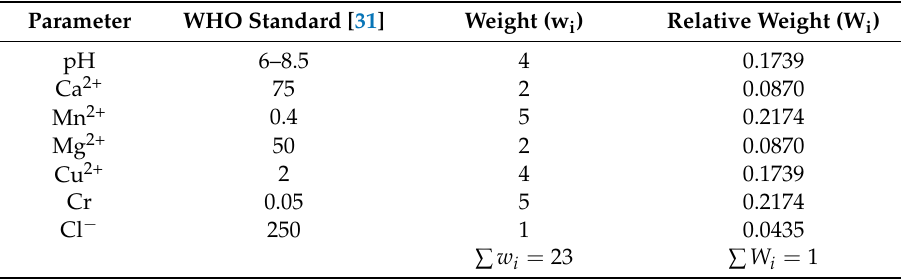
Table 2. The relative weight of chemical parameters.